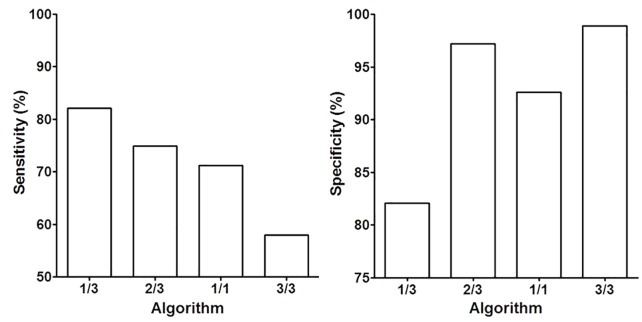
The Epi proColon 2.0 CE assay exhibited high sensitivity and specificity in CRC detection.The sensitivity and specificity of the Epi proColon 2.0 CE assay in the opportunistic screening study with various algorithm were shown. Values for sensitivity were shown on the left panel and values for specificity were shown on the right panel for 1/3, 2/3, 1/1 and 3/3 algorithm.